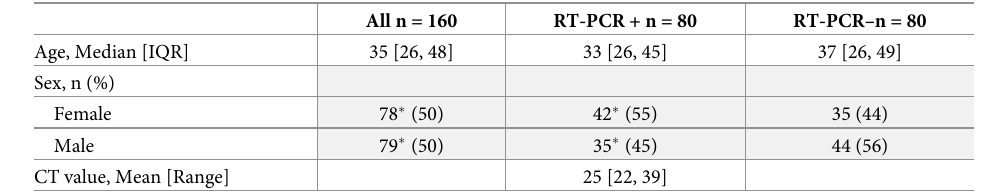
Table 1. Demographics of